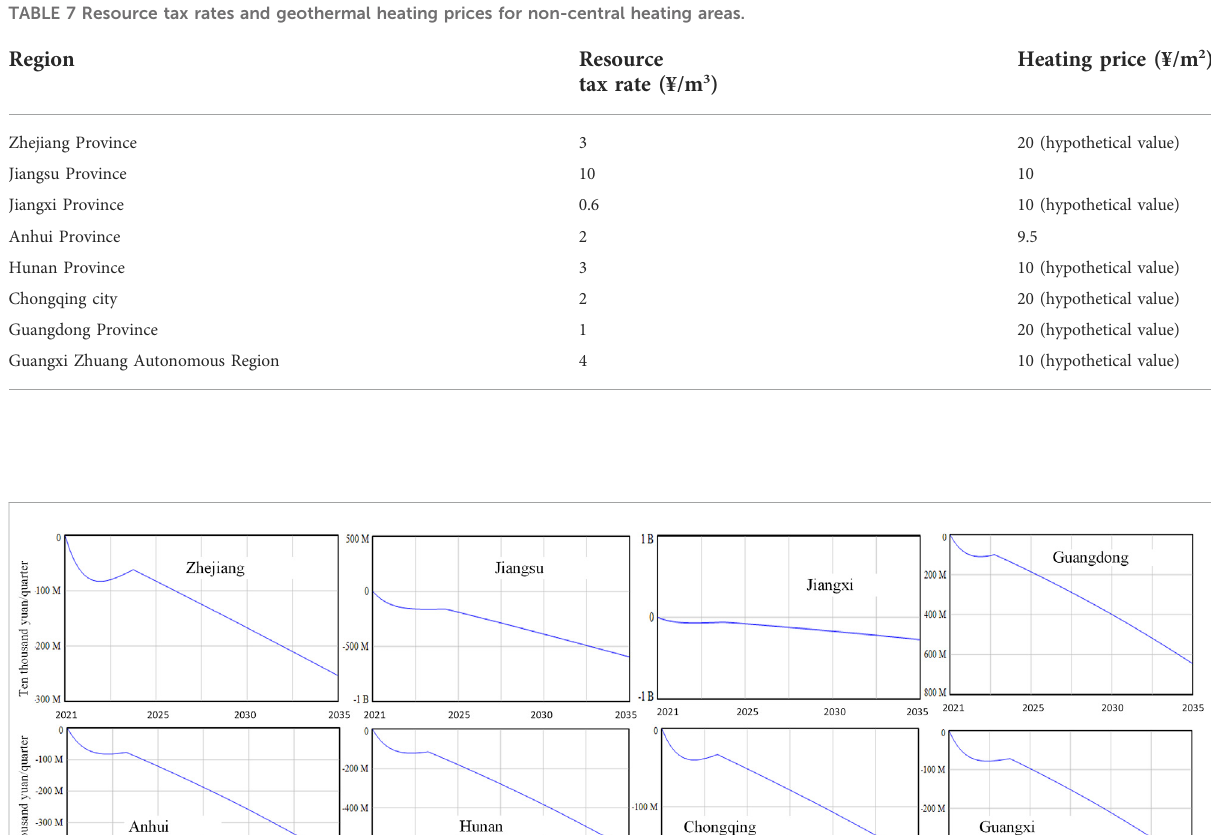
TABLE 7 Resource tax rates and geothermal heating prices for non-central heating areas.